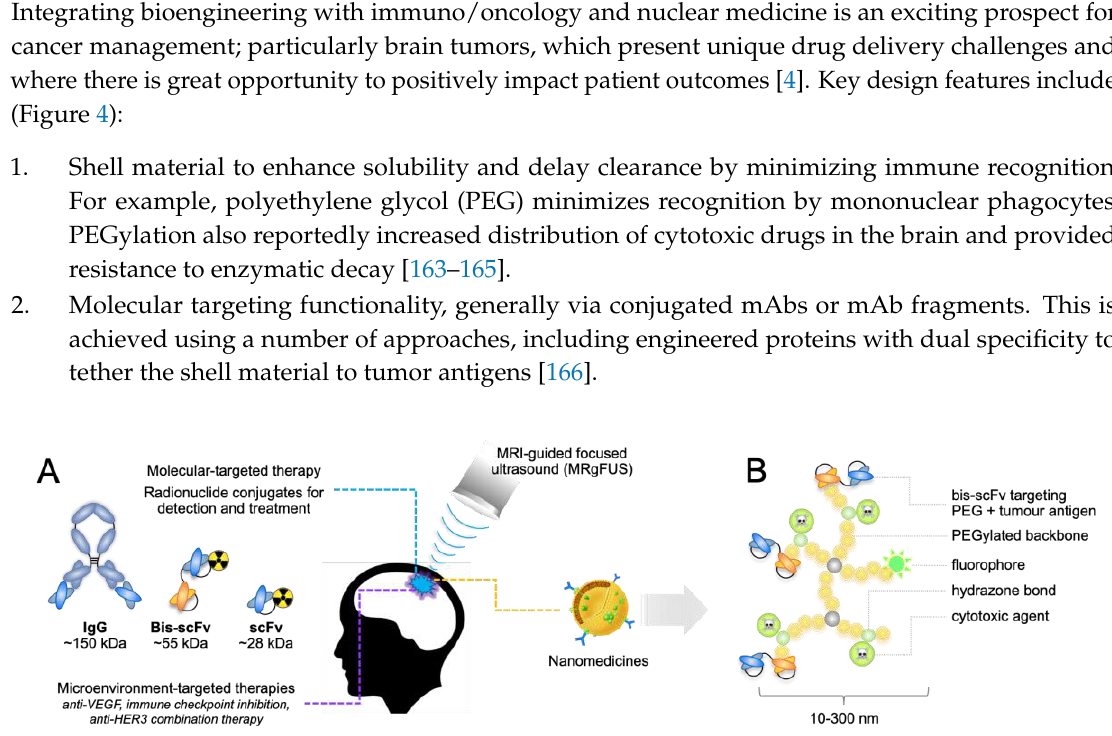
Figure 4. Emerging strategies for detection and treatment of brain metastases. ( A ) Bioengineering and molecular oncology research are beginning to identify approaches that specifically target vulnerabilities of brain metastases, including microenvironmental adaptations. Through flexibility of design, nanomedicine approaches offer exciting possibilities for overcoming drug delivery and therapeutic index challenges in the metastatic brain cancer patient population. Externally-augmented drug release and/or activation may be a useful therapeutic tool in some circumstances. ( B ) Typical structure of a polymer-based nanocarrier with various functional groups. bis-scFv, bispecific single-chain variable fragment; IgG, immunoglobulin; kDa, kilodalton; nm, nanometer.